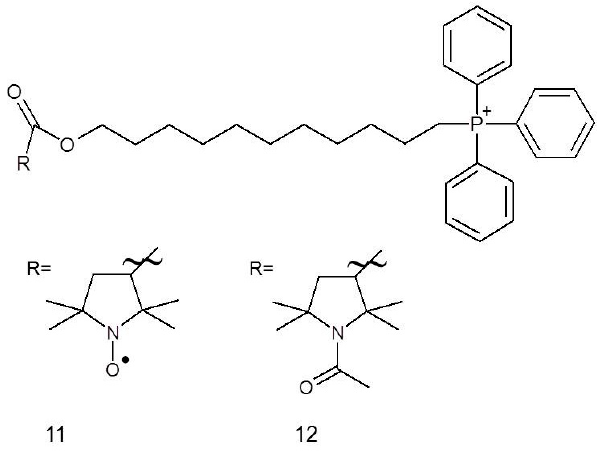
Figure 3. Nitroxides and their nonparamagnetic derivatives used as anticancer drugs: ( 11 , 12 ) Mito-Cp 11 and Mito-Cp 11